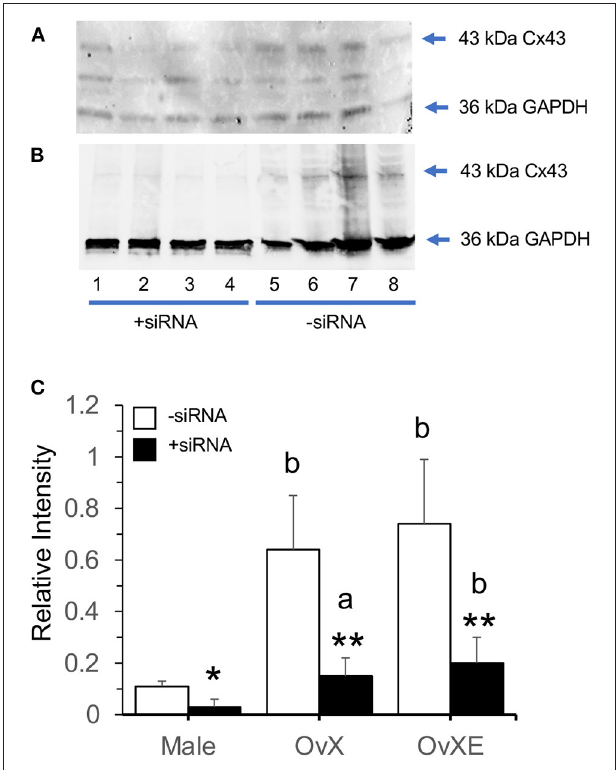
FIGURE 3 | Western blots for Cx43 of TG tissue from OvXE (A) and male rats (B) at 10 days after CFA and treated with siRNA for Cx43 or with PBS by intra-TG injection 3 days prior to tissue collection. (C) Summary of the effects of siRNA for Cx43 on protein levels in the TG of male, OvX, and OvXE females.